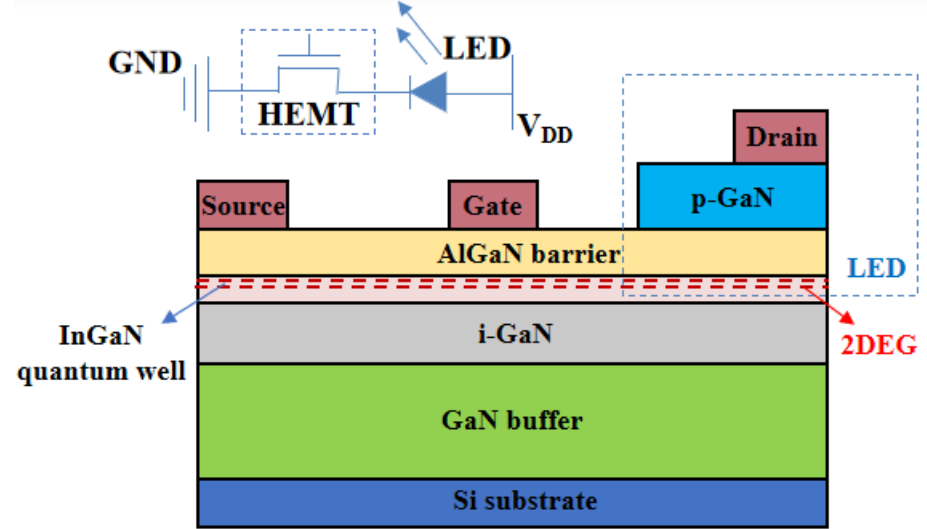
Figure 12. Monolithically integrated LED − HEMT structure.